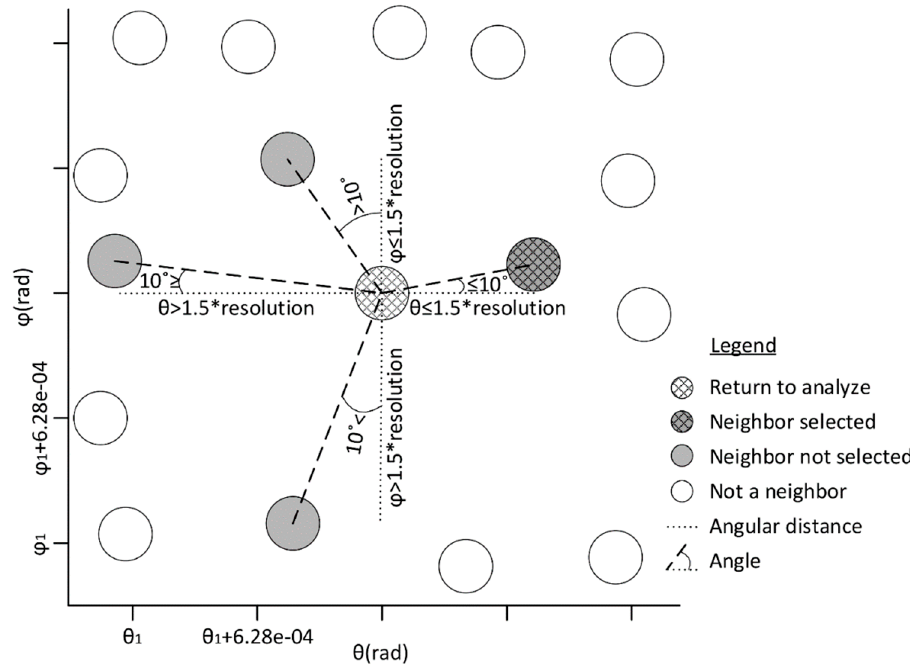
Figure 2. Algorithm to select neighbor laser returns.